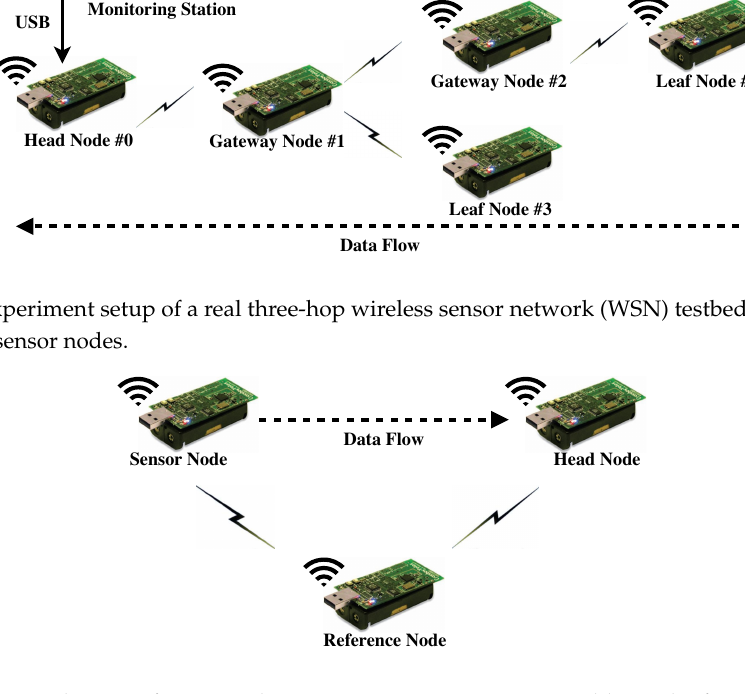
Figure 6. Evaluation of time synchronization accuracy using one additional reference